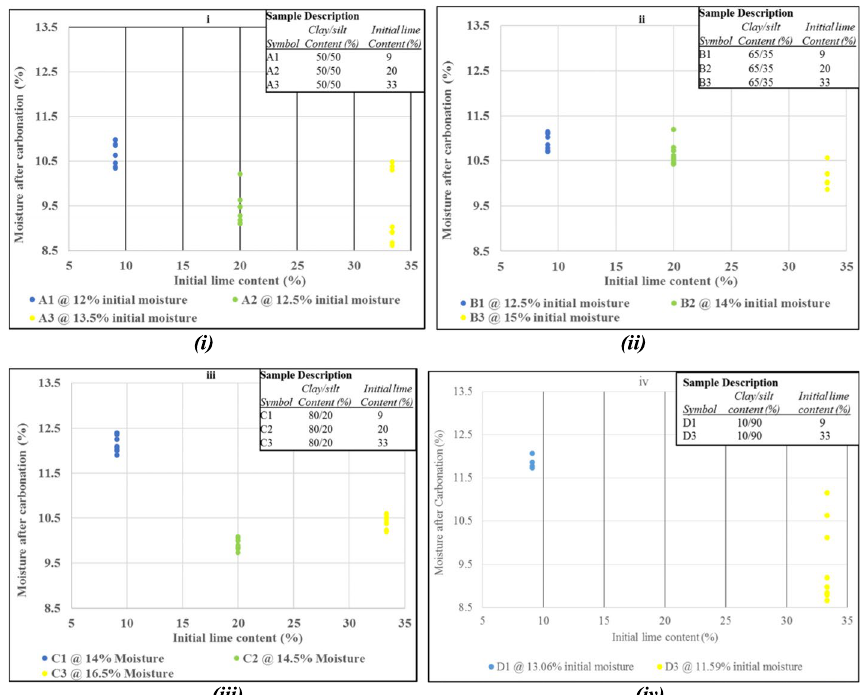
Fig. 4 Relationship between amount of lime carbonated and moisture retained